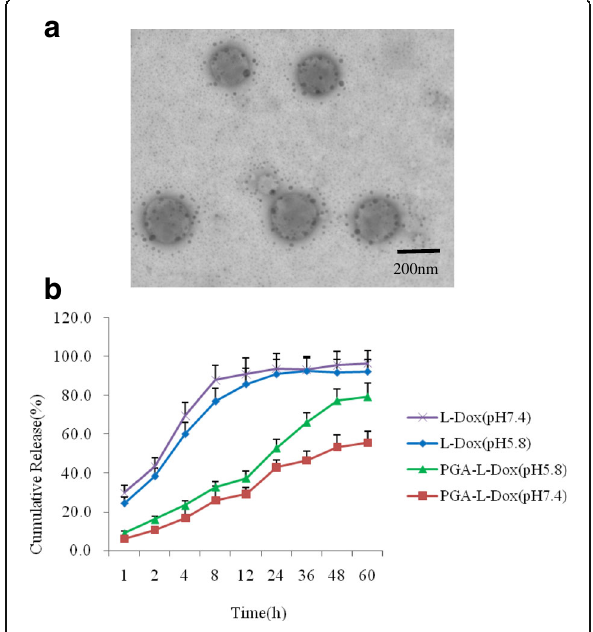
Fig. 1 a TEM image of γ -PGA-coated Dox lipoplexes. b In vitro release profiles from PGA-L-Dox and L-Dox in PBS at pH 5.8 and 7.4. Each data was represented as mean ± SD ( n = 3)